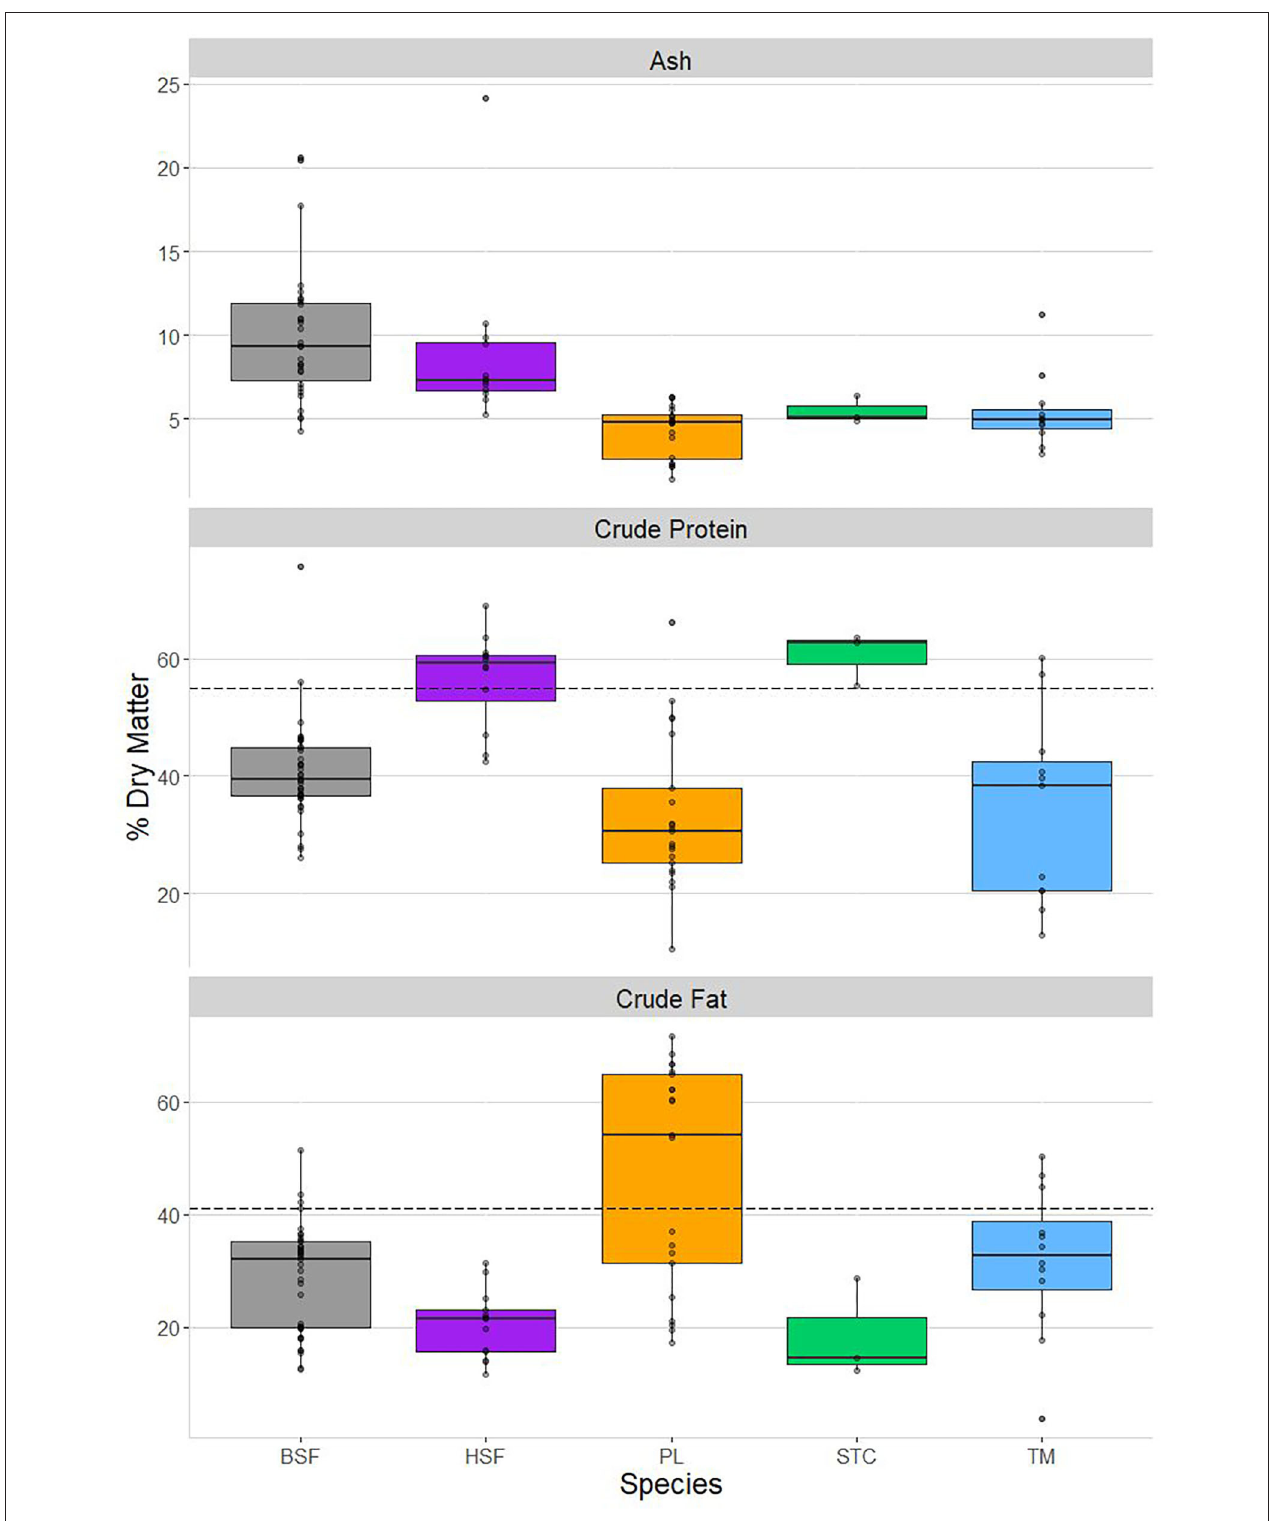
FIGURE 1 | Proximate content, on a % dry matter basis, using both data analyzed in this paper and literature-sourced data. From top to bottom: ash, crude protein, and crude fat content. From left to right: Hermetia illucens (black soldier fly, BSF; in gray), Musca domestica (house fly, HSF; in purple), Rhynchophorus phoenicis (palm weevil, PL; in orange), Cirina butyrospermi (shea tree caterpillar, STC; in green), and Macrotermes bellicosus (termite, TM; in blue). The horizontal hashed lines in the bottom two panels represent the crude protein and crude fat content of beef, respectively, obtained from van Huis et al. (24).